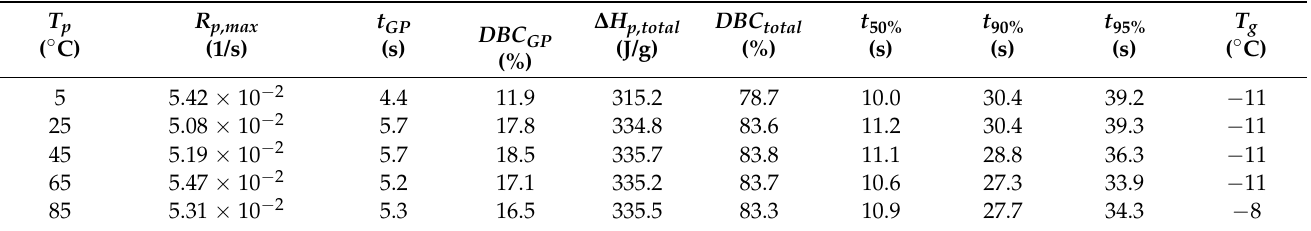
Table 2. Photo reactivity of UrA containing 1 wt.% TPOL under N 2 atmosphere at different tempera- tures obtained from photo-DSC